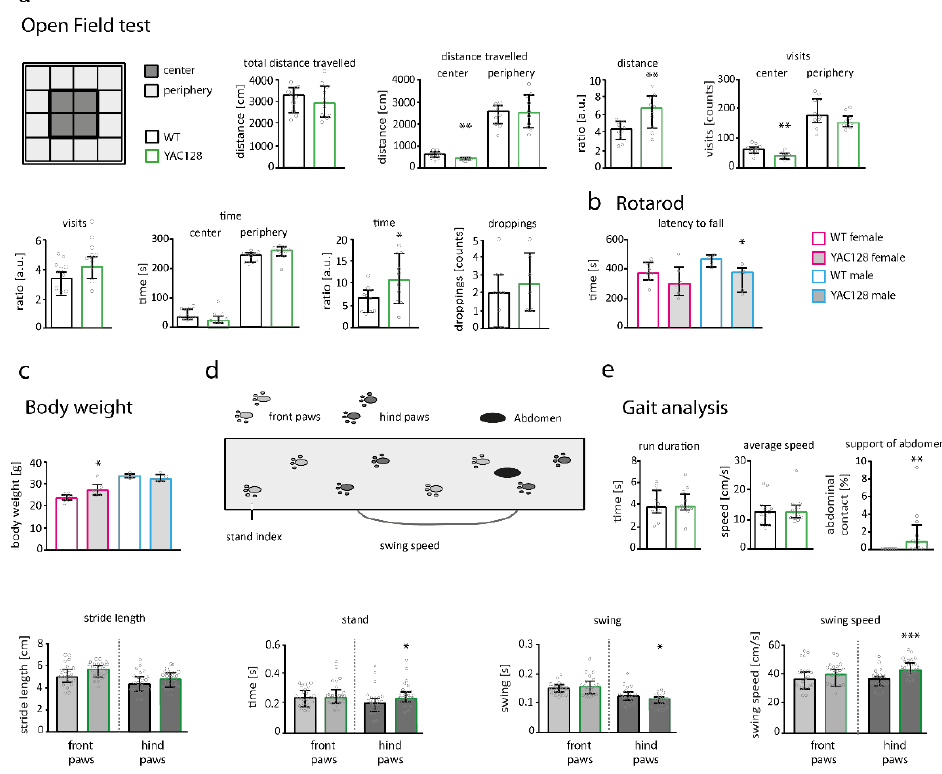
Figure 6. Behavior is impaired in 9-month-old YAC128/BL6 mice. ( a — left ) Scheme of the Open Field divisions with center and periphery. ( a — right ) Bar graphs of Open Field behavioral parameters of WT ( n = 10) and YAC128/BL6 ( n = 10) mice. ( b ) Bar graph of the latency to fall off the Rotarod for male and female WT (n females = 7; males = 6) and YAC128/BL6 (n females = 4, males = 5) mice. ( c ) Bar graph of the median body weight of female and male of WT and YAC128/BL6 mice. ( d ) Scheme of the gait analysis (Catwalk) setup. ( e ) Bar graphs of gait analysis parameters from WT ( n = 11) and YAC128/BL6 ( n = 12) mice. Bar graphs are depicted as median ± IQR. * = p < 0.05, ** = p < 0.01, *** = p <